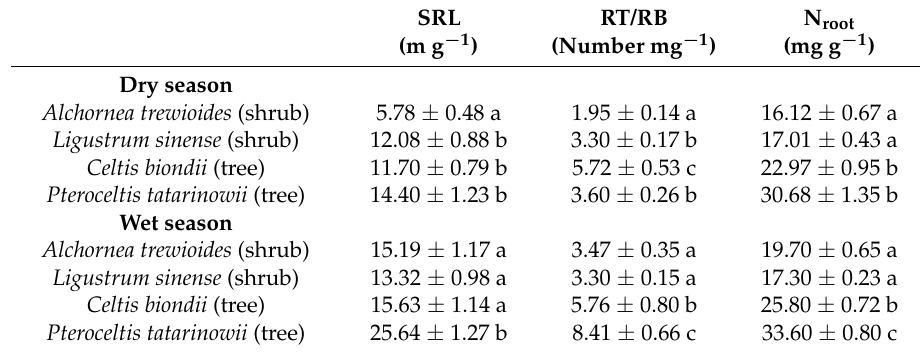
Table 2. Specific root length (SRL), root tips over the root biomass (RT/RB), and N concentrations (N root ) in fine roots of the four study plant species in the dry (from October to March) and the wet (from April to September) season in a karst ecosystem of southwest China (mean ± SE).